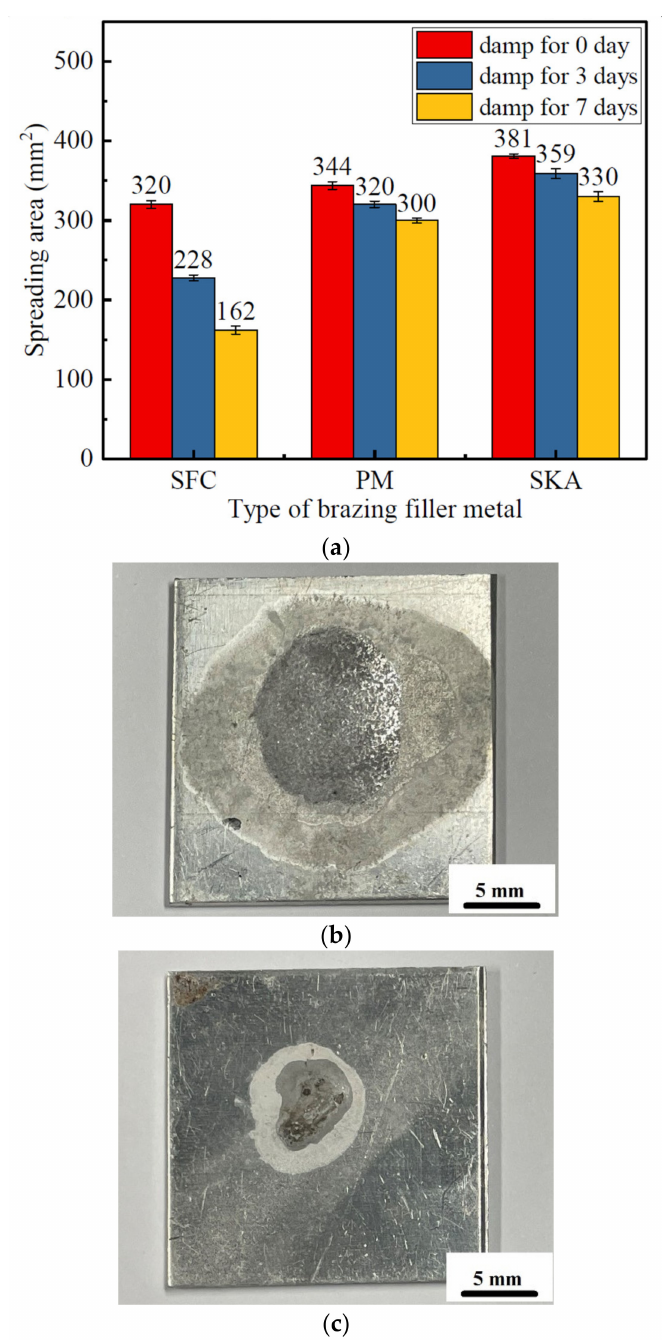
Figure 6. Spreading area of different brazing filler metals under different conditions: ( a ) Change of spread area of the brazing filler metals; ( b ) The sample of spreading before the powder flux is exposed to moisture; ( c ) The sample of spreading after the powder flux is exposed to